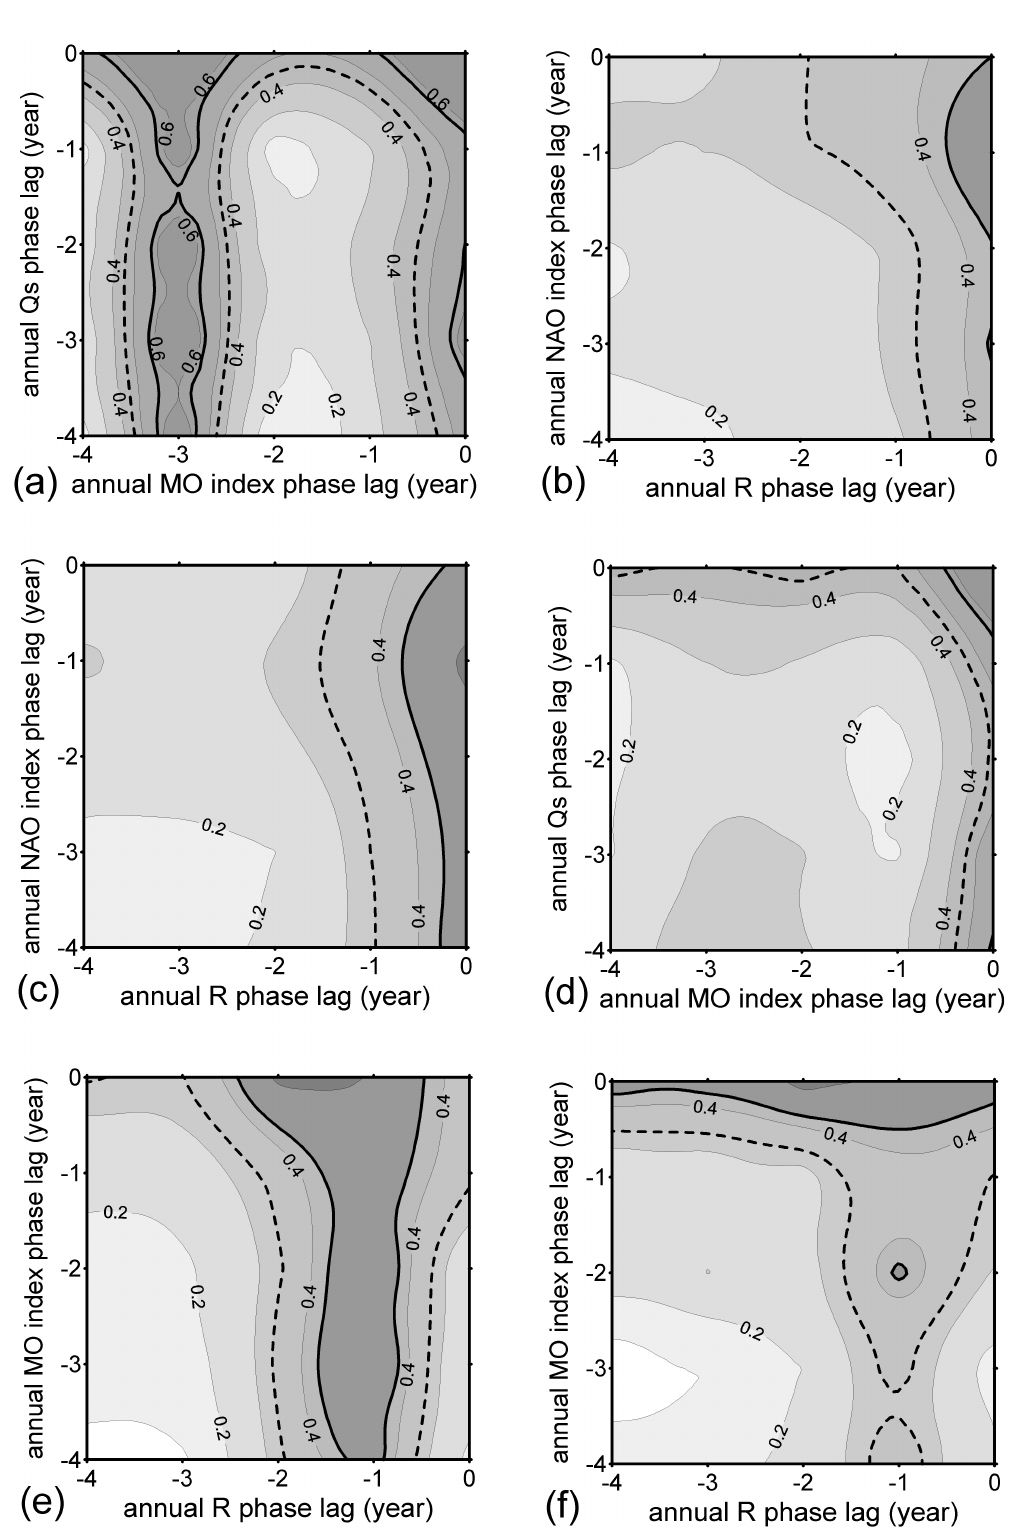
Fig. 8. Double correlation coefficients for the cases when maximum correlation appeared for annual surface (a) temperature, (b) salinity and (c) density, and annual bottom (d) temperature, (e) salinity and (f) density measured at RV001 station. Input parameters are varied between Qs, P, R, the MO and NAO indexes (dashed and thick line stands for 95% and 99% significance level, respectively) for phase lags from 0 to − 4